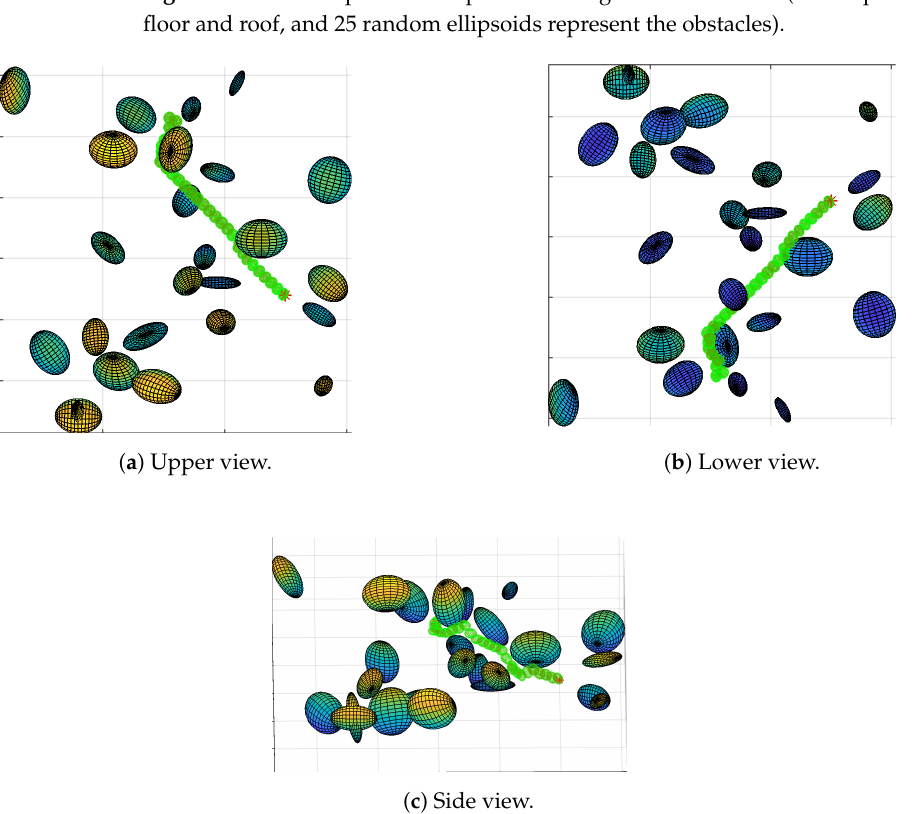
Figure 8. Path of map 1 generated with TLBO. The green ellipsoids represent the path obtained, the asterisk represent the target and the multicolor ellipsoids represent the obstacles. It can be seen that the path is sufficiently smooth for a drone to follow